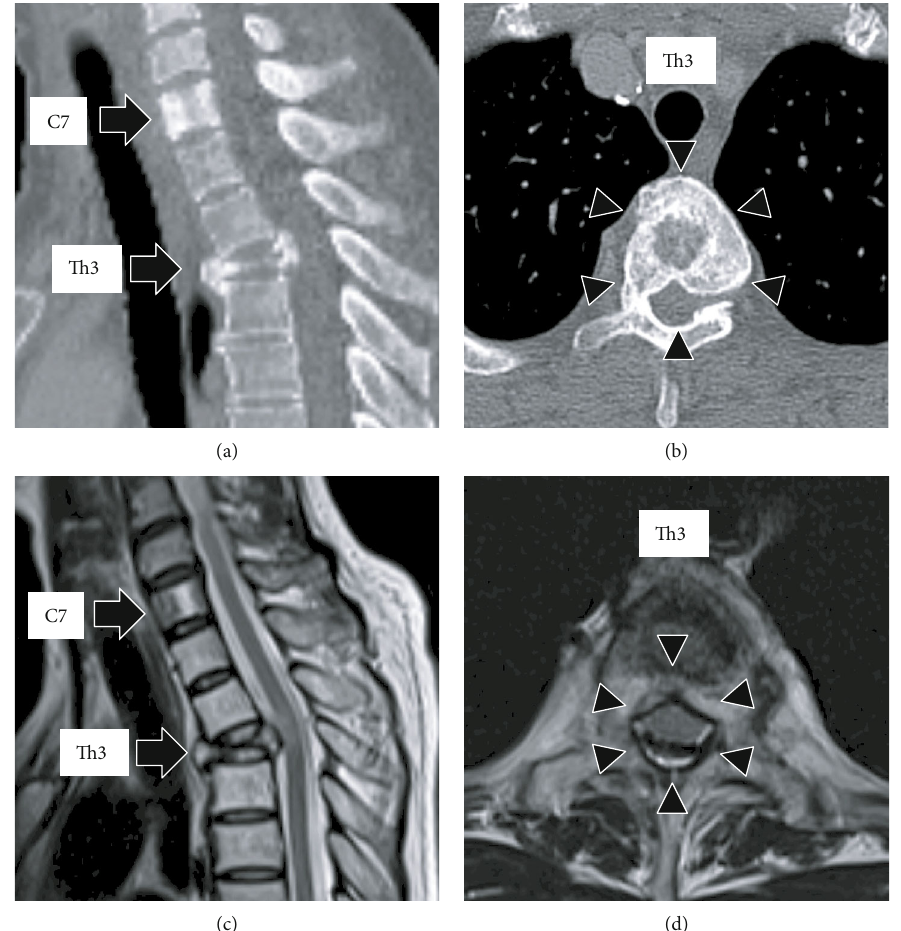
Figure 4: (a, b) Sagittal and axial views of the thoracic spine on computed tomography (CT) after 1 year of multimodality treatment showing osteosclerosis (arrowhead) of the C7 and Th3 vertebral bodies (arrow). (c, d) Sagittal and axial views of the magnetic resonance imaging (MRI) after 1 year of multimodality treatment showing tumor shrinkage in the C7 and Th3 vertebral bodies (arrow), enlarging the spinal canal